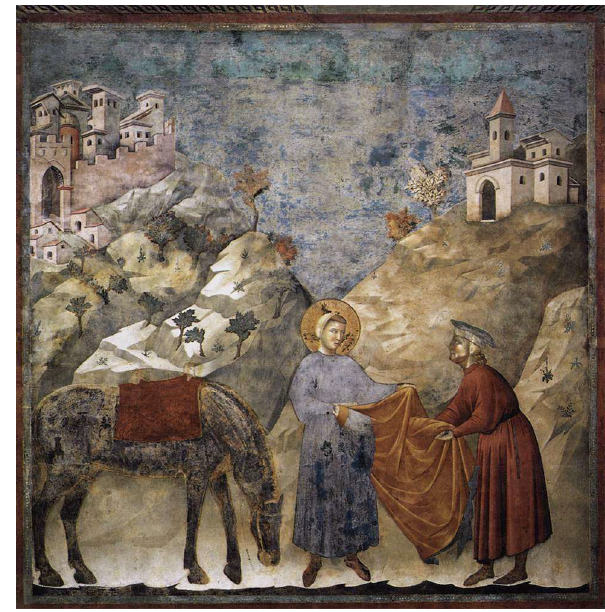
Figure 19. St. Francis gives his mantle to a poor man (1297–1299). Wiki